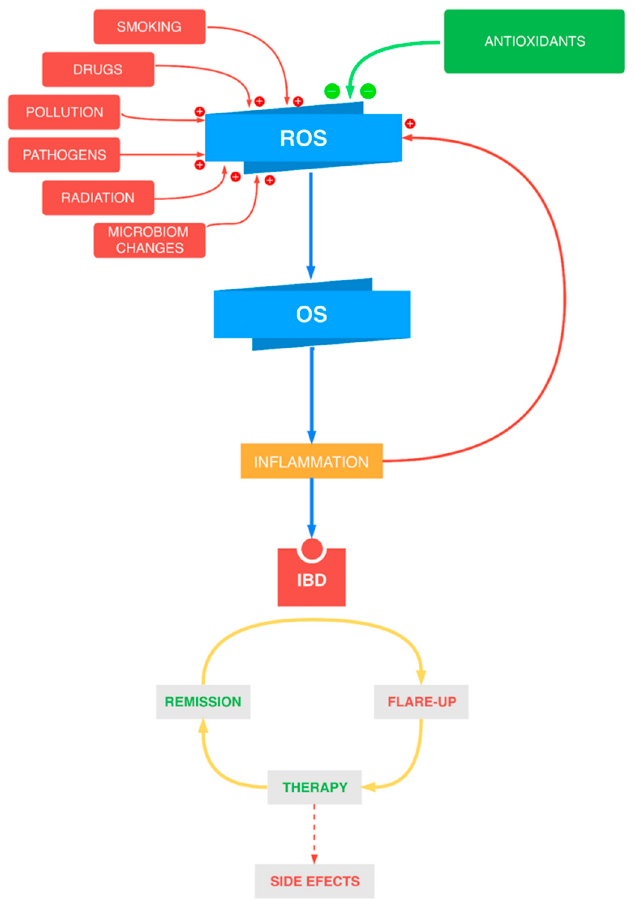
Figure 1. The connection between oxidative stress (OS) and inflammatory bowel diseases (IBD) and the key role of the antioxidants. ROS—reactive oxygen